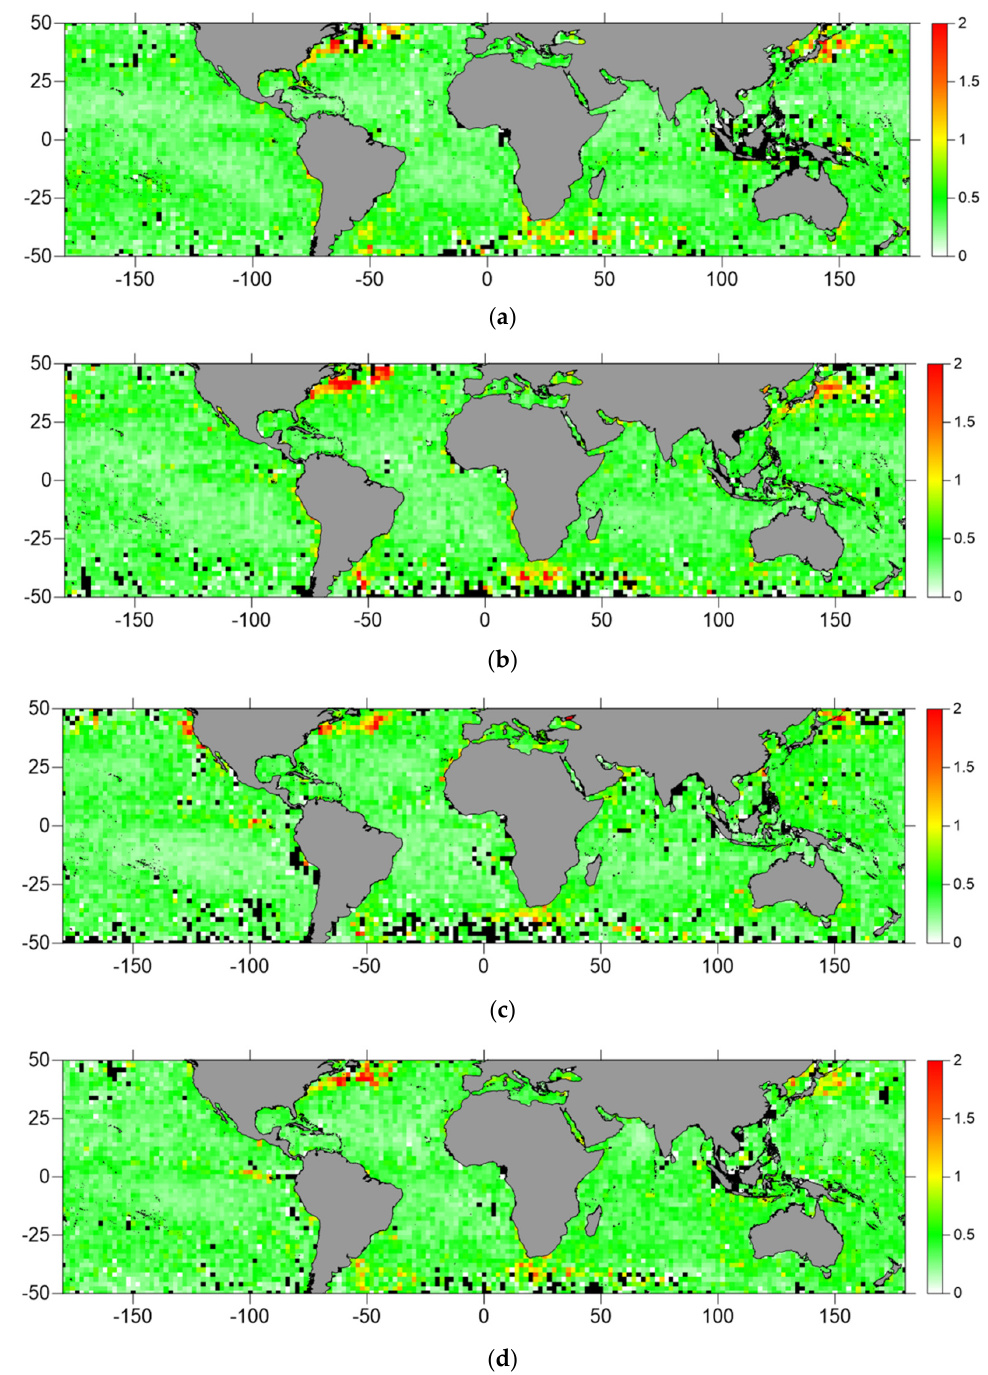
Figure 2. Maps of the standard deviation of SST skin differences, in K, between the Sentinel-3A SLSTR sensor and the ERA5 atmospheric model (SST SLSTR ₋ SST ERA5 ), derived for Sentinel-3A SRAL cycles 13, 17, 21 and 24 (subpanels ( a )–( d ), respectively), represented with a 2° by 2° spatial resolution. Blank pixels are shown in black.